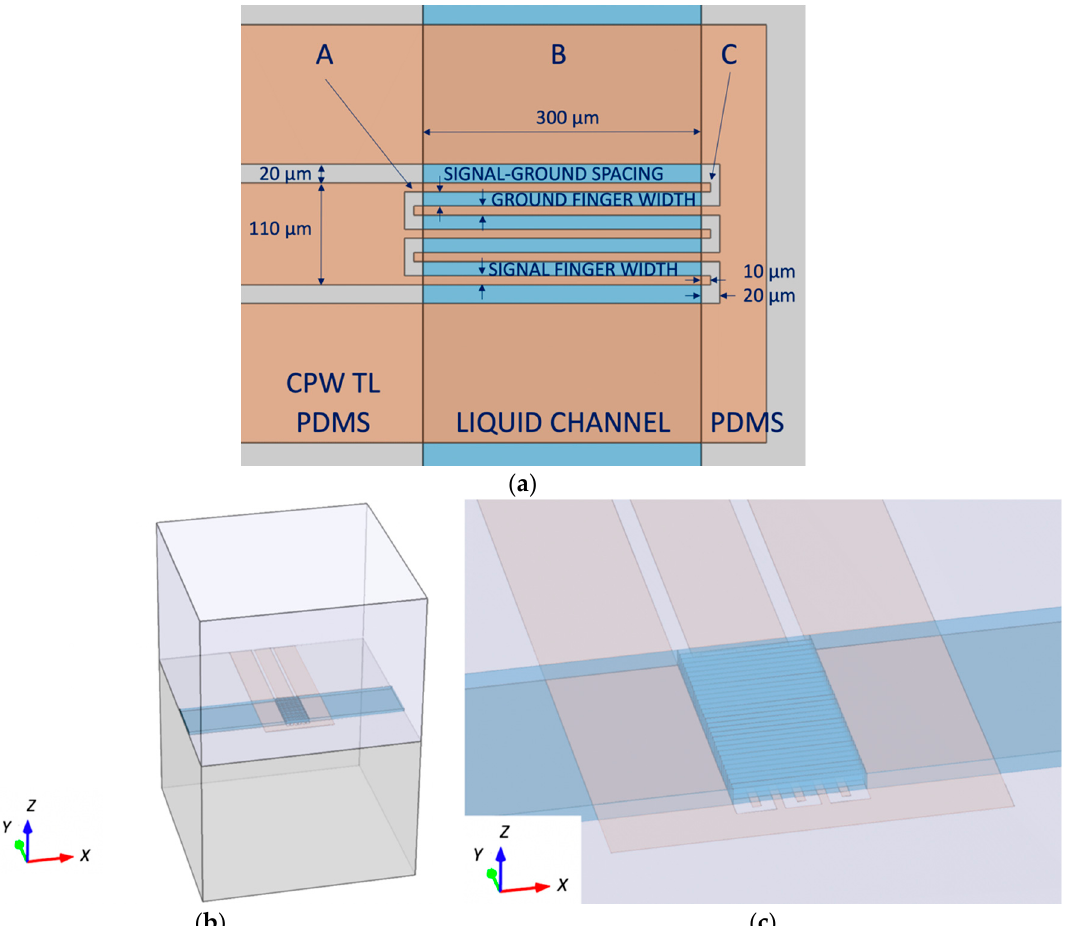
Figure 1. ( a ) The IDC design space: signal and ground finger widths and their mutual spacing. ( b ) A COMSOL Multiphysics® simulation model of an IDC on quartz covered by PDMS; ( c ) A close-up COMSOL Multiphysics ® simulation model of an IDC on quartz covered by PDMS; ( c ) A close-up view of 10 µ m wide water sections used for optimizing IDC dimensions for uniform view of 10 µm wide water sections used for optimizing IDC dimensions for uniform heating.